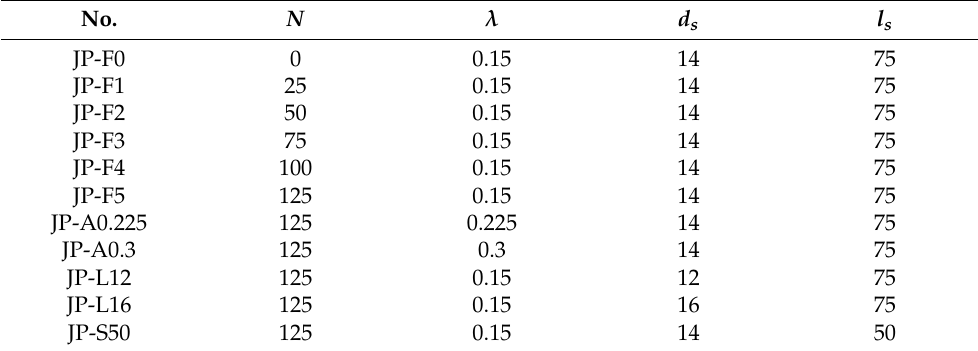
Table 1. Parameters of the